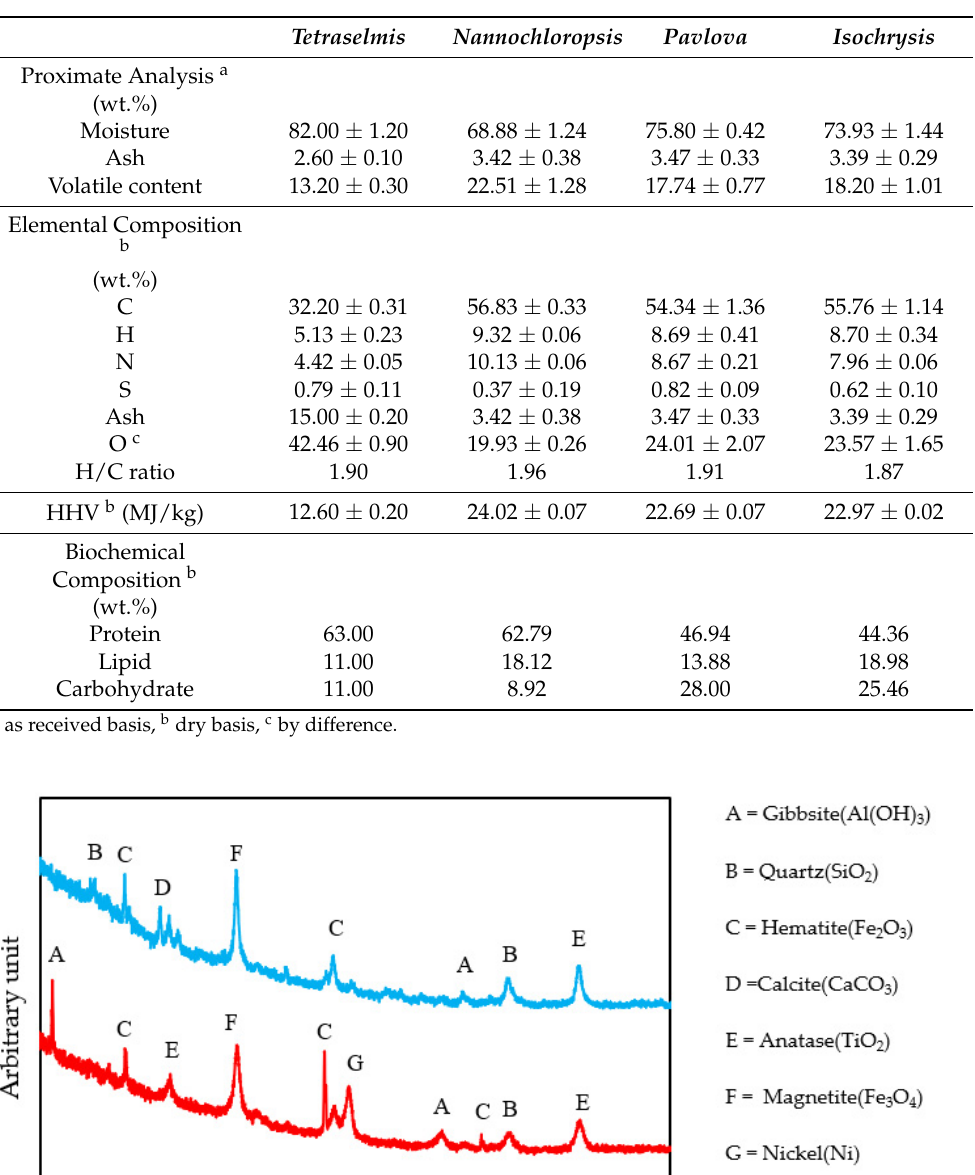
Table 1. Characterization of Tetraselmis sp. feedstock and comparison with other algae strains [43].